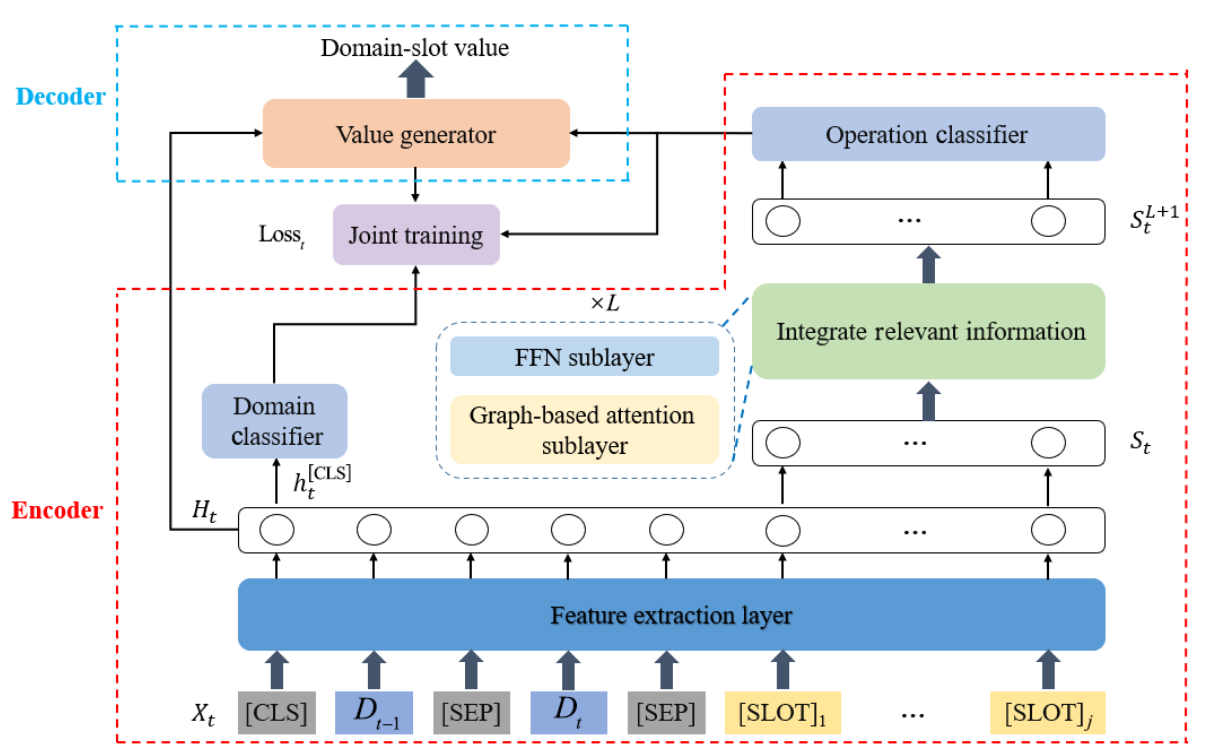
Fig. 1 Architecture of the proposed